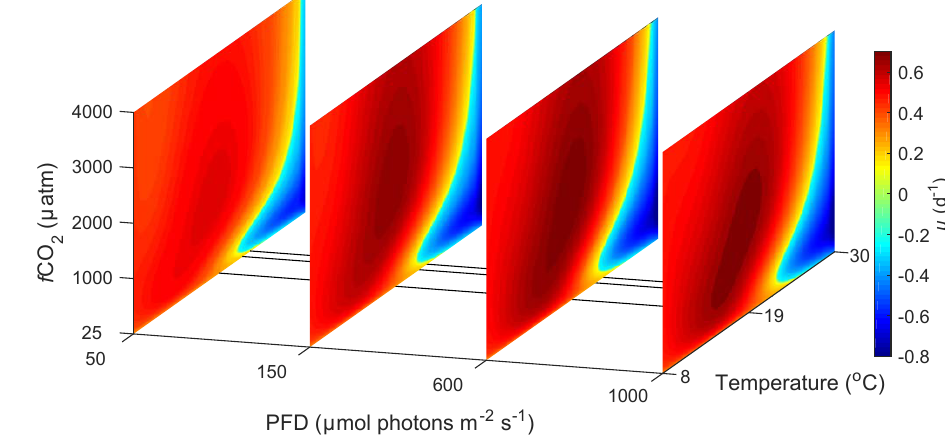
Figure 3. Predicted difference in growth rates between E. huxleyi and G. oceanica across a temperature range of 8–30 ◦ C and a f CO 2 range of 25–4000µatm at 50, 150, 600 and 1000µmolphotonsm − 2 s − 1 of PAR based on Eq. (2). Note that the response to varying CO 2 or temperature is not significantly influenced by light intensity. Note the positive values indicate E. huxleyi dominance while negative values indicate G. oceanica dominance.